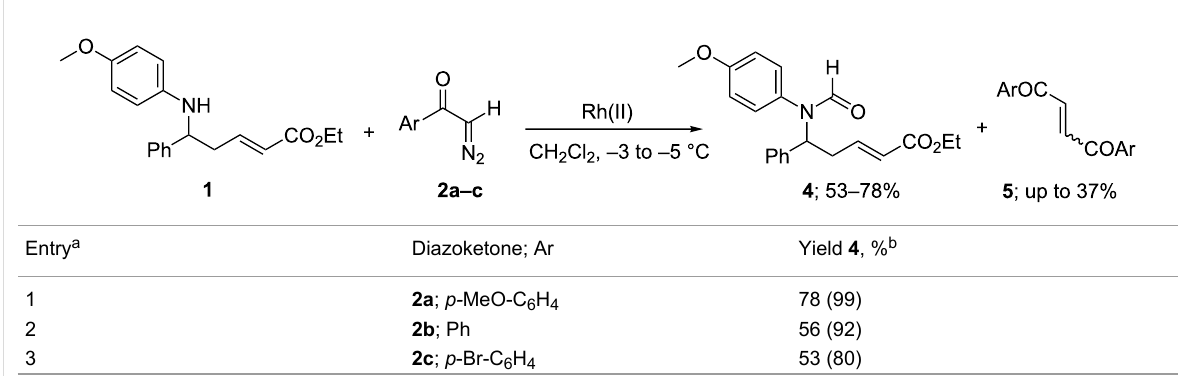
Table 1: Rh(II)-Catalyzed reactions of diazoketones 2a–c with aminoester 1 .